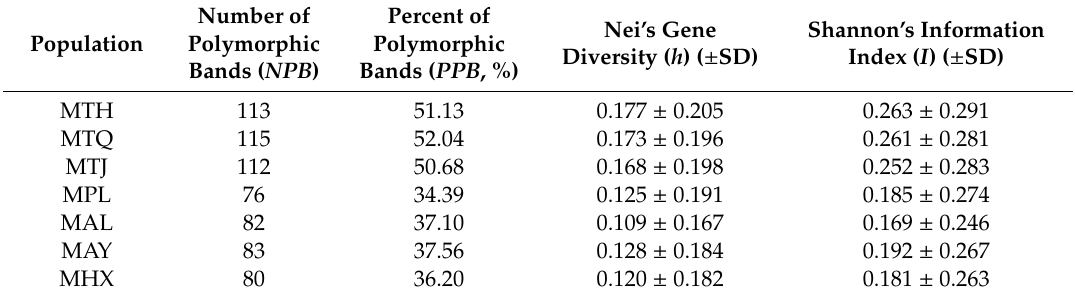
Table 3. Genetic diversity of 7 populations in the genus Megalobrama at 15 SRAP loci.